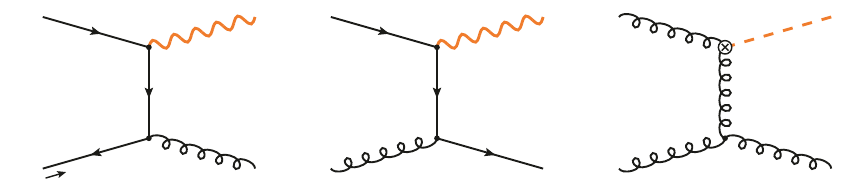
Figure 1. Tree-level Feynman diagrams for electroweak boson production with large transverse momentum at hadron colliders. For EW gauge boson (orange wiggly lines) production example diagrams of two different production channels are